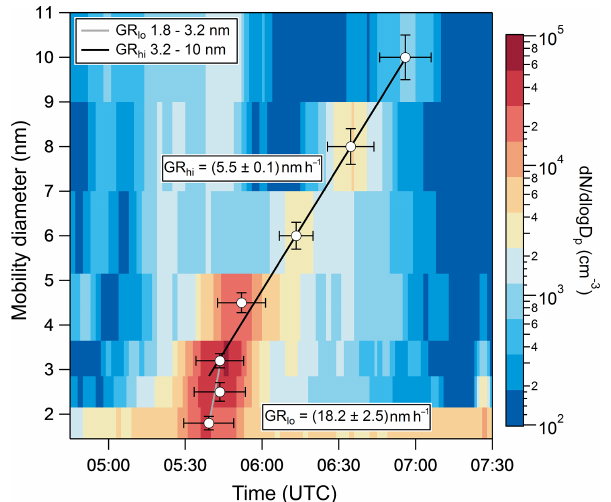
Figure 3. Event on 16 April 2017. The set mobility diameter in each size channel is plotted versus the time of the mode peak (white markers) with the time series of the number size distribution in the background. The growth rate can be directly determined from the slope of the fit to the diameter by applying a linear fit using an orthogonal distance regression. DMA-train growth rates are typi- cally divided into two size intervals, which also applies to this am- bient data set. In this example from 16 April 2017, an initial growth rate of 18.2nmh − 1 in the lower size interval (1.8–3.2nm) is cal- culated. The growth rate in the higher size interval (3.2–10nm) is 5.5nmh − 1 . Note the linear scale on the y